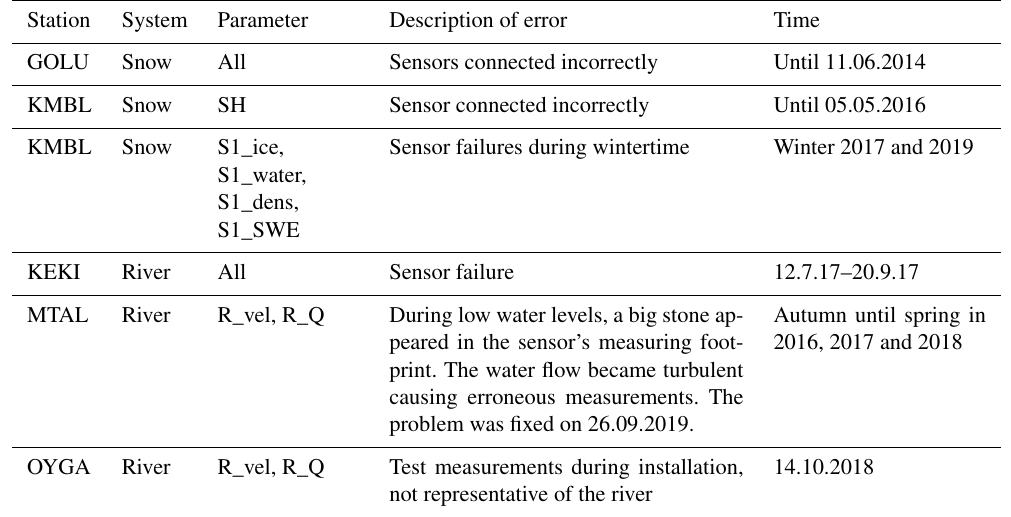
Table 9. List of problems in the hydrological parameters